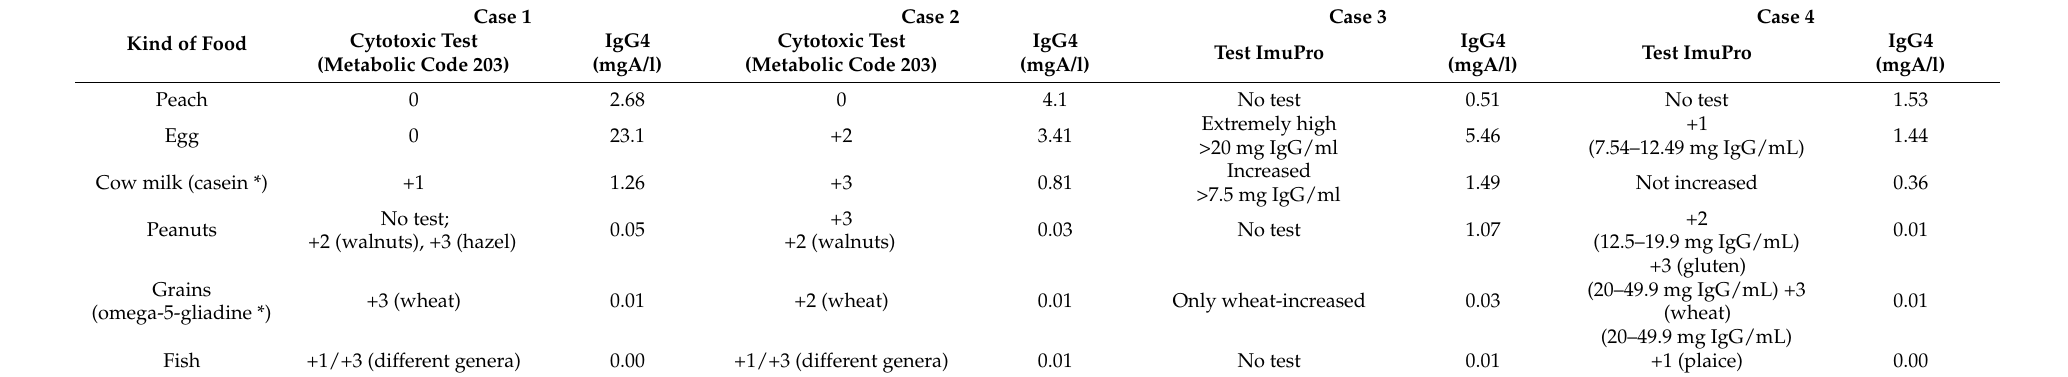
Table 1. Results of IgG4 concentration measurements and food intolerance tests (cytotoxic test and ImuPro test).